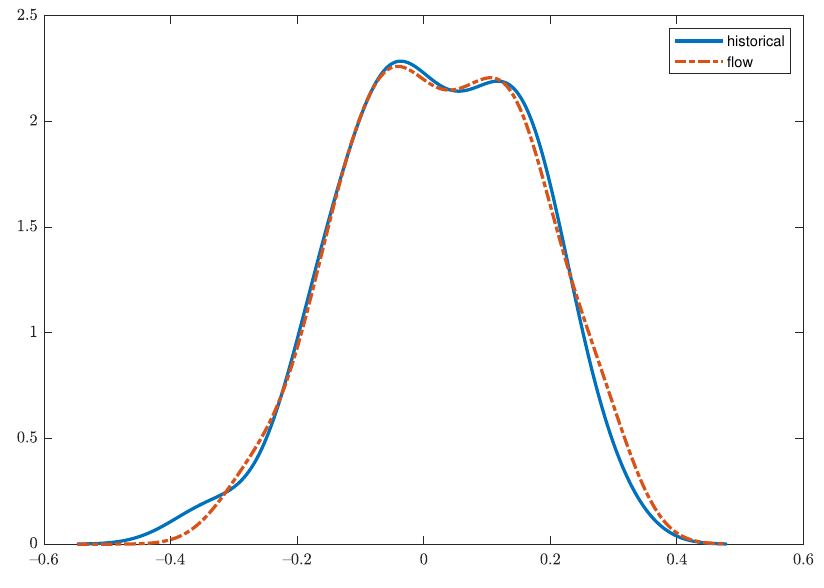
Figure 3. Empirical density function of the historical correlation and the correlation flow between S&P 500 and Euro/US-Dollar exchange